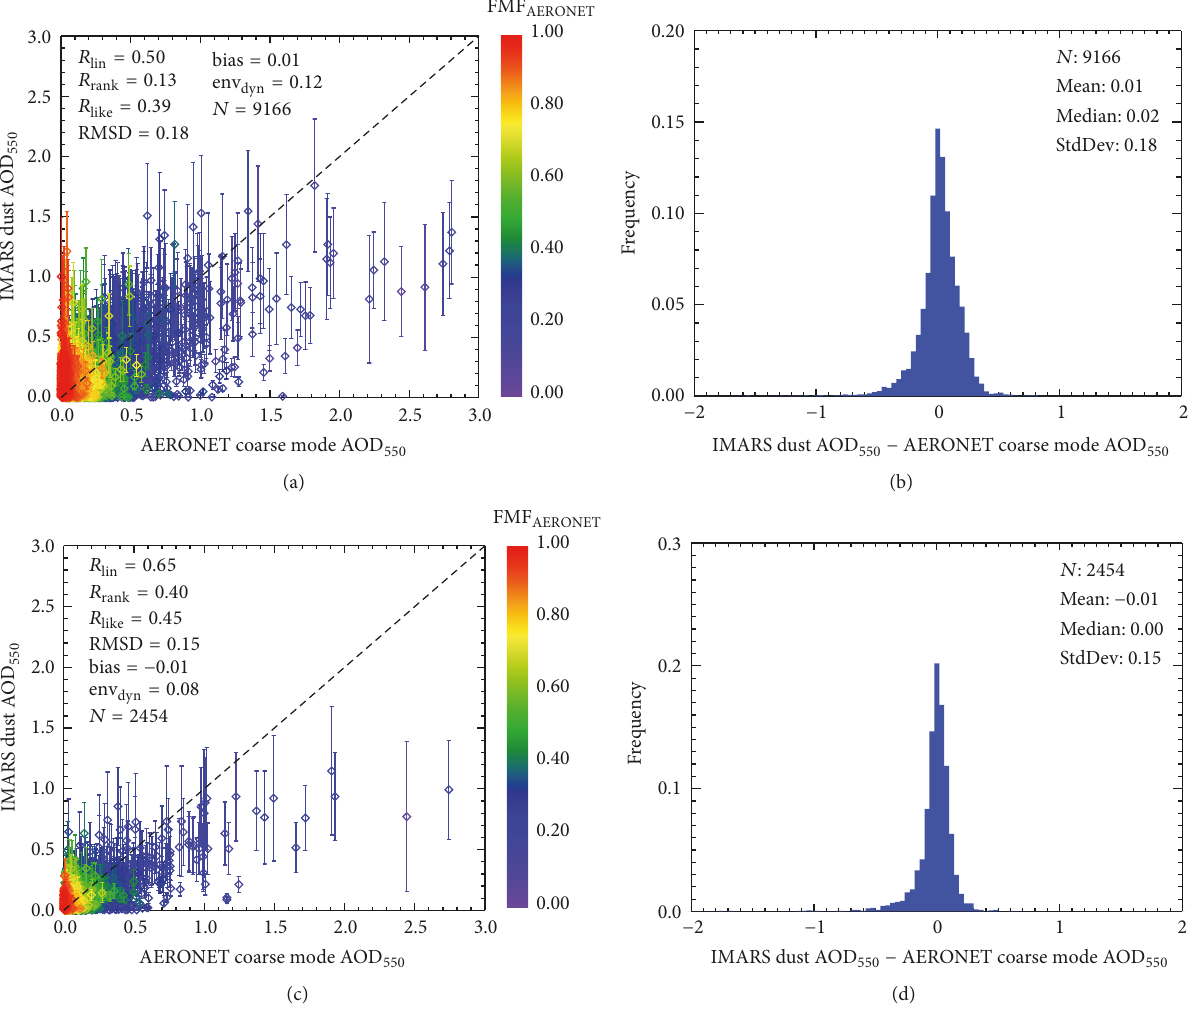
Figure 9: IMARS dust AOD evaluation results against AERONET SDA L2.0 coarse mode AOD in terms of scatter plots (a, c) and deviation histograms (b, d) for IASI observations over land (a, b) and ocean (c, d). Symbol colours represent the SDA retrieved aerosol fine mode fraction (FMF) from AERONET. Observations of 73 AERONET stations for the year 2009 have been used for